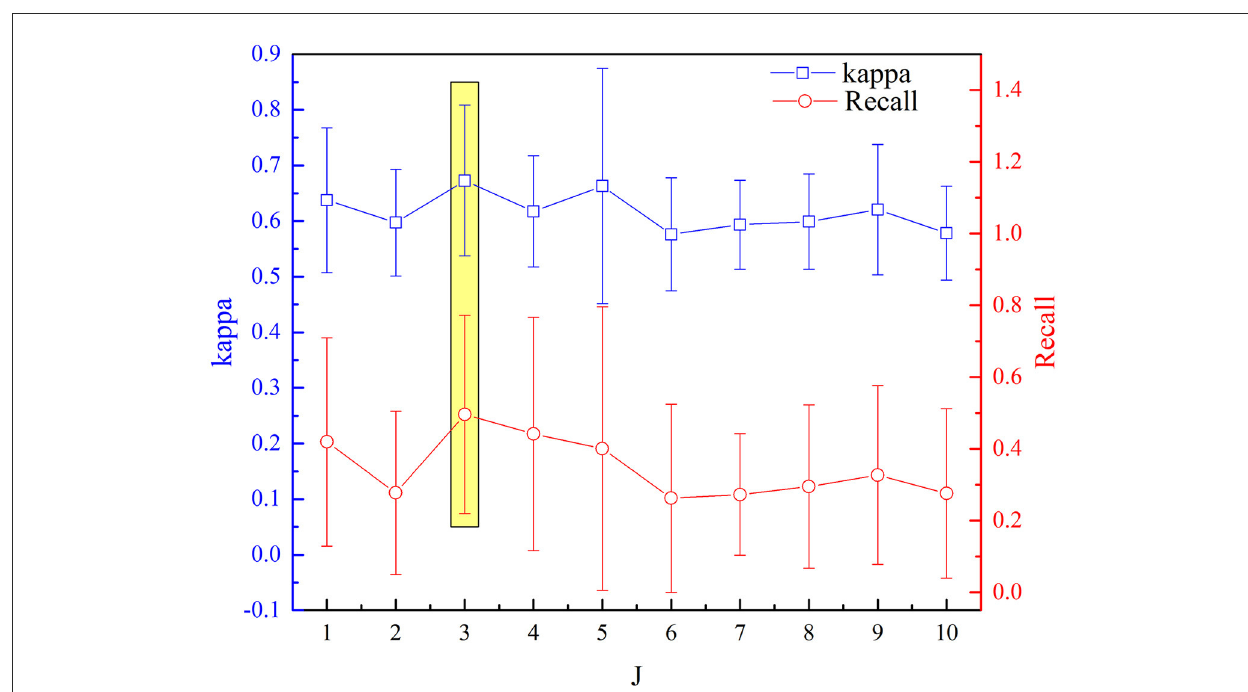
FIGURE7 Variation of kappa and recall value with J for the detection of k-complexes.